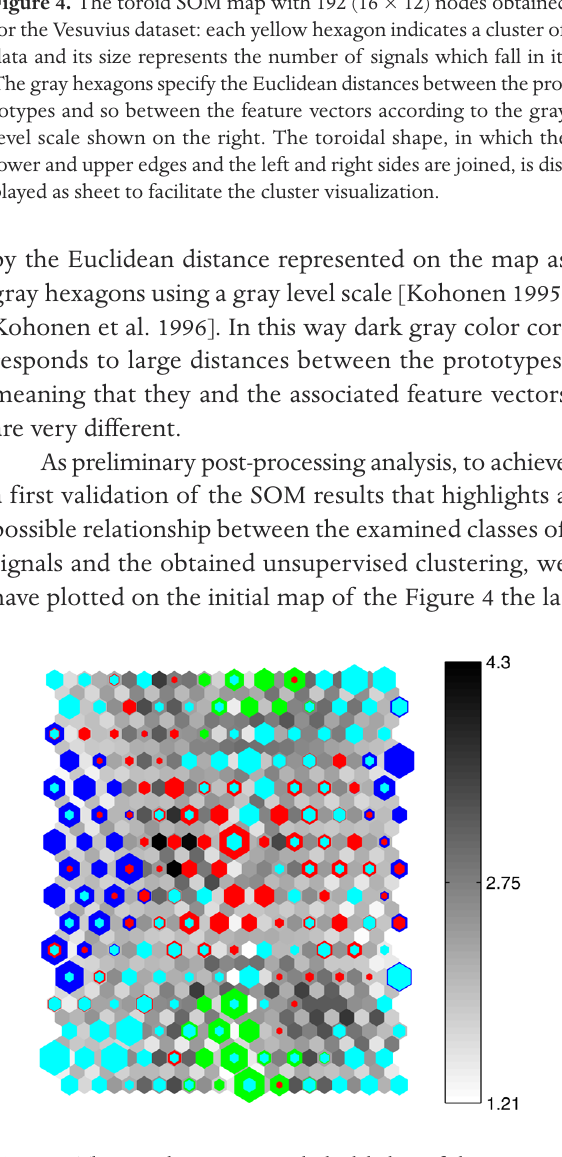
Figure 5. The toroid SOM map with the labeling of the events re- alized by the experts: green for the earthquake class, red for the landslide class, blue for the artificial explosion class and cyan for the class “other”. The hexagons with color overlap indicate the nodes in which fall signals belonging to different